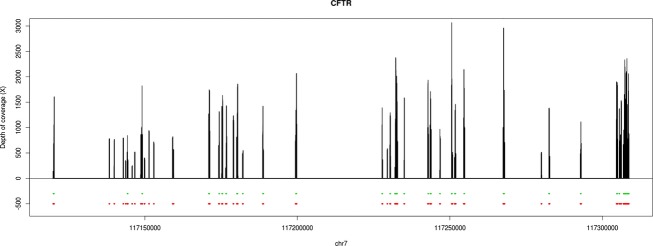
Representation of the average depth of coverage of CFTR across the 177 patients. Green lines represent the exons of the gene. Red lines represent the amplicons of the assay.